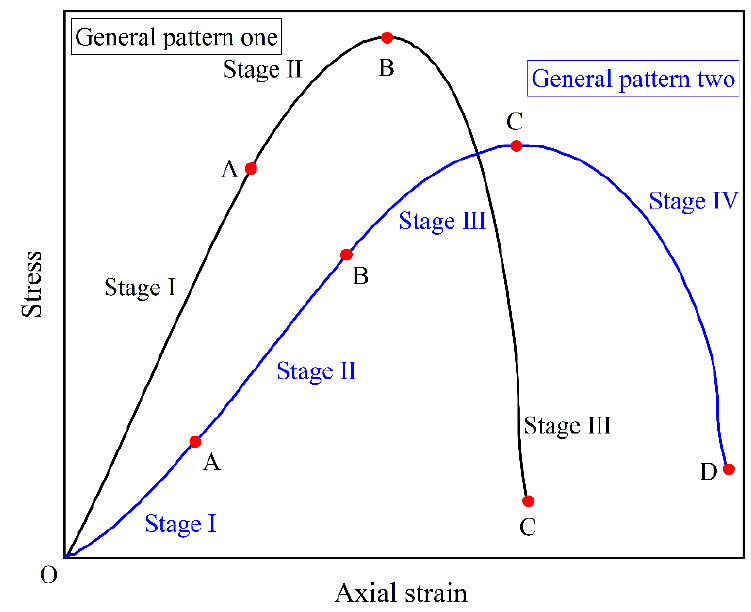
Figure 10. Dynamic stress-strain curves of sandstone.